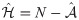
Invasion boundaries as a function of different levels of resident investment in the independent reproduction rate are represented by dashed lines.Open circles indicate the values of the traits of the residents. Shaded areas are invasion areas. Trade-off is assumed as in Fig 2. Free host population is H^=N−A^, where N is the total number of hosts. ESS value is the tangent point (closed circle) between the invasion boundary and the convex trade-off curve (A) and concave trade-off curve (B). Parameter values: b = 3, ν = 3, c = 2, σ = 0, μ0 = 3, βmax = 5, ω = 6.5, N = 100, (A) α = 0.7, δ = 1.3, (B) α = 3.1, δ = 1.3.